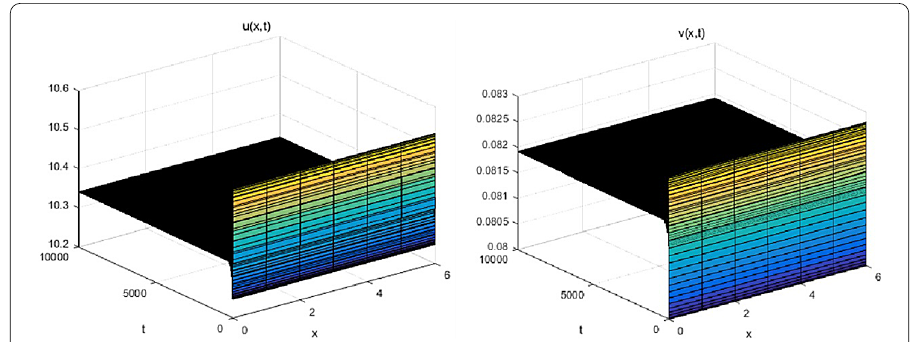
Figure 2 The numerical simulations of system (1.4) with parameters in (4.1) and d 1 = 0.01, d 2 = 0.2, r 1 = 0.2. Left: component u is locally asymptotically stable. Right: component v is locally asymptotically stable